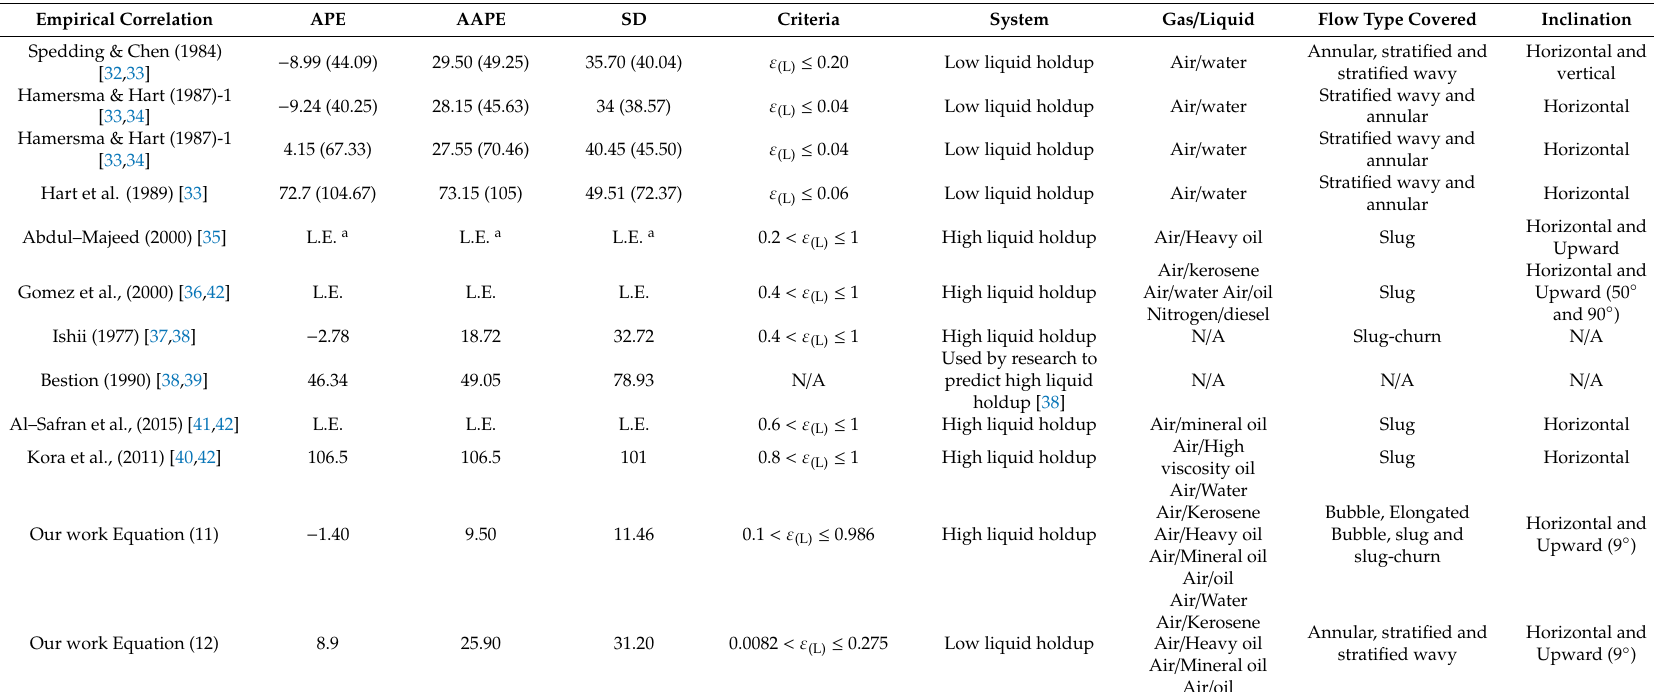
Table 2. Evaluation of the proposed correlation and the correlations from the